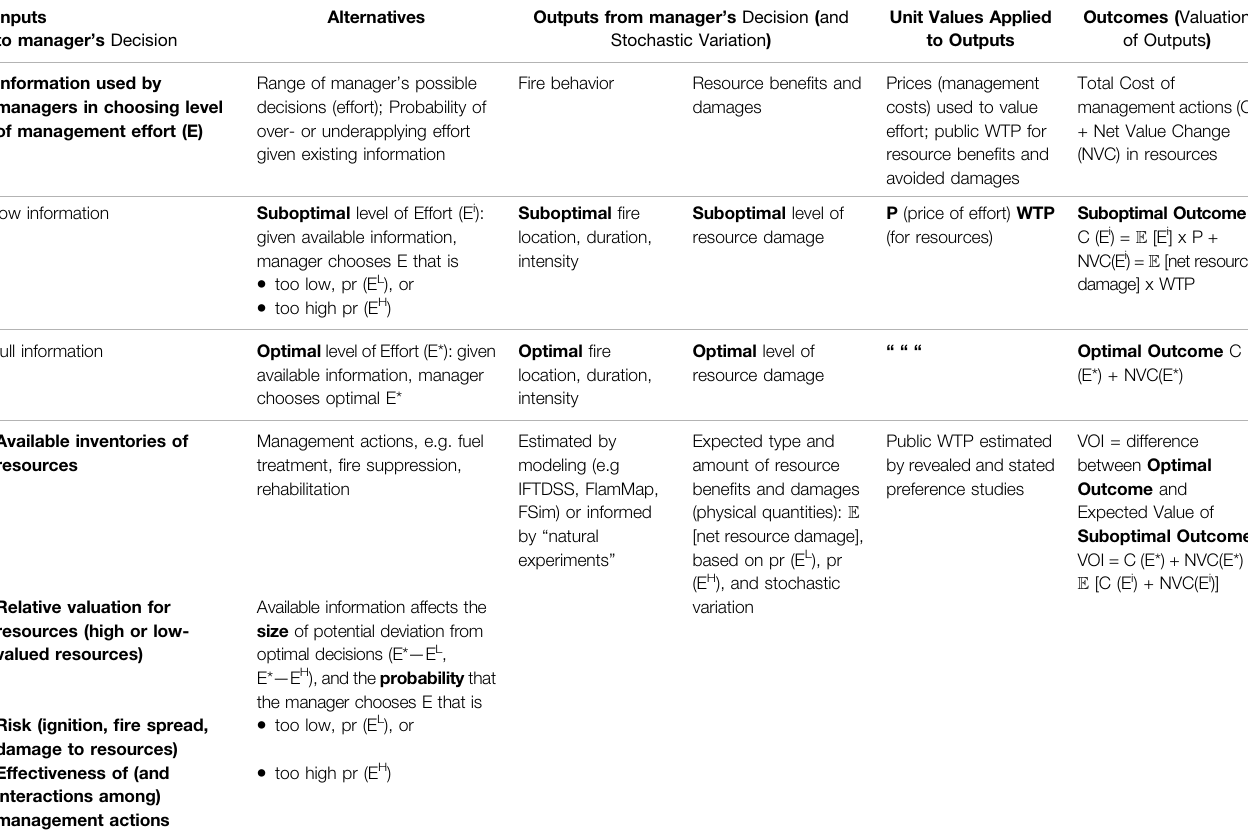
TABLE 1 | Conceptual components of VOI for a wildland fi re manager ’ s decision (level of management